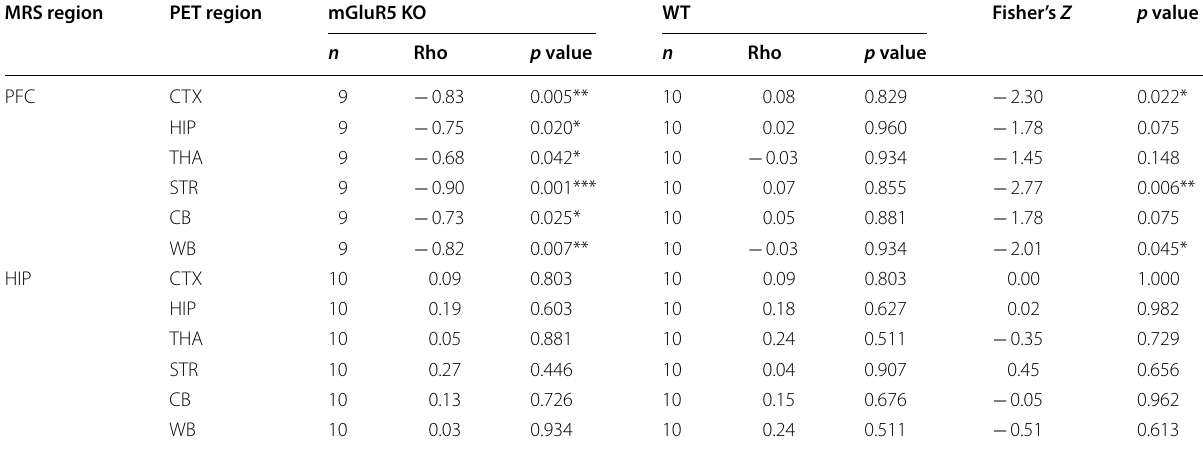
Table 5 Correlation coefficients between cortical glutamate levels and baseline [ 18 F]FDG PET results (SUV with Fisher’s Z-transformation